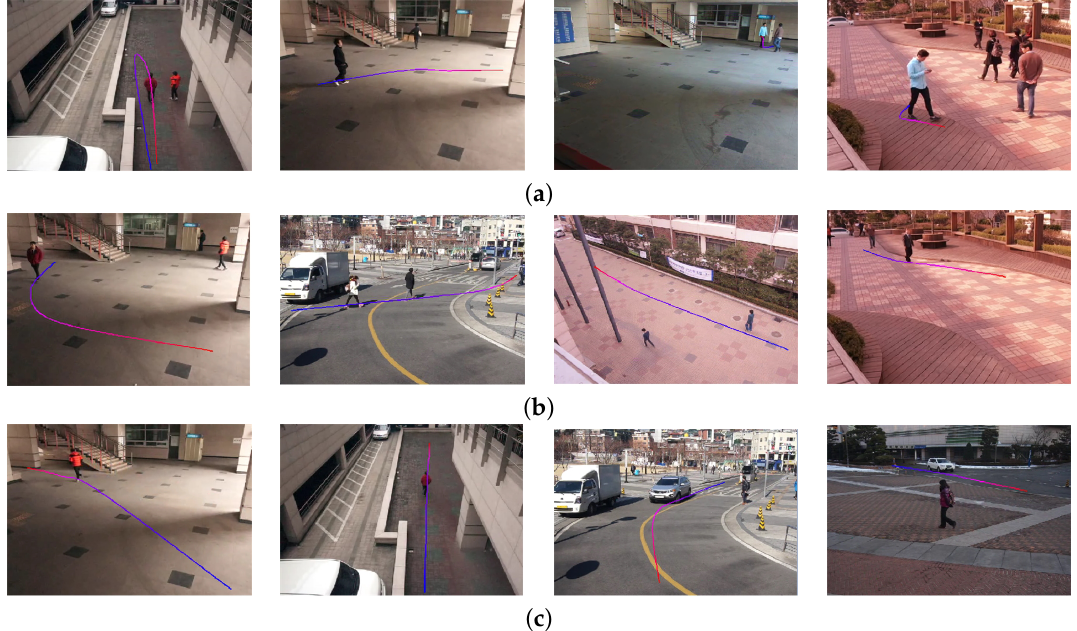
Figure 19. Results of the object search using the object speed. ( a ) Slow; ( b ) normal; ( c )